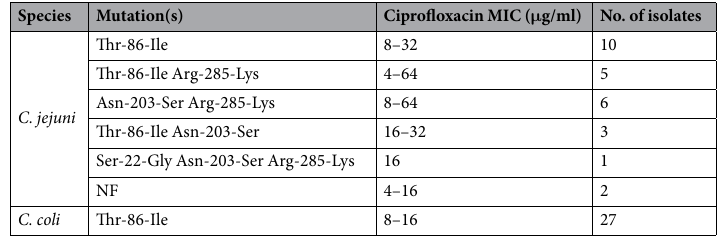
Table 4. Point mutations observed in the QRDR of GyrA in FQ R C. jejuni (n = 27) and C. coli (n = 27) isolates. NF: no point mutation found in